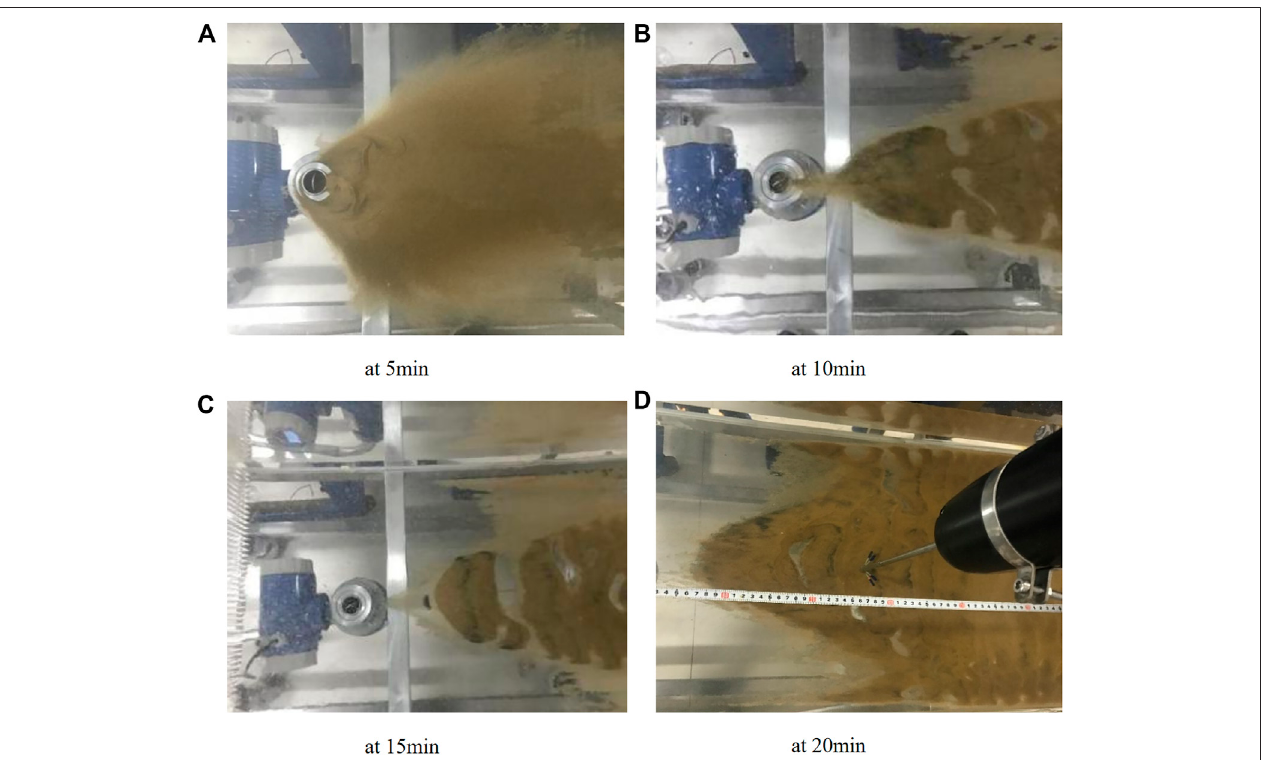
FIGURE 8 | Top view of the experimental process.